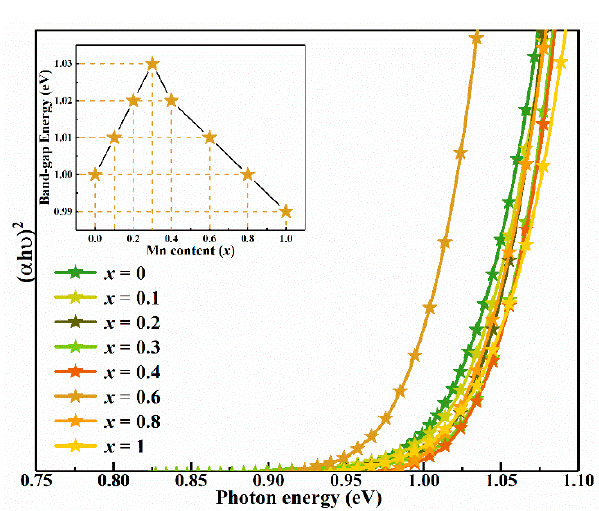
Figure 6. Plot of ( α h υ ) 2 against h υ for the Cu 2 Mn x Zn 1 − x Sn(S,Se) 4 (0 ≤ x ≤ 1) alloy thin films. Inset: band gap variation as a function of the Mn content.